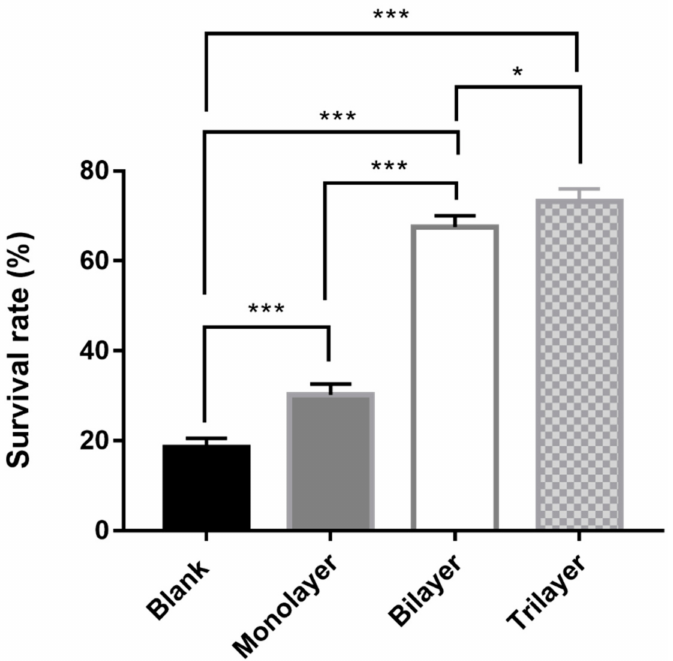
Figure 6. Survival rate of free and encapsulated L. casei K17 immediately after freeze-drying. Values (mean ± SE, n = 3), * p < 0.05, *** p <